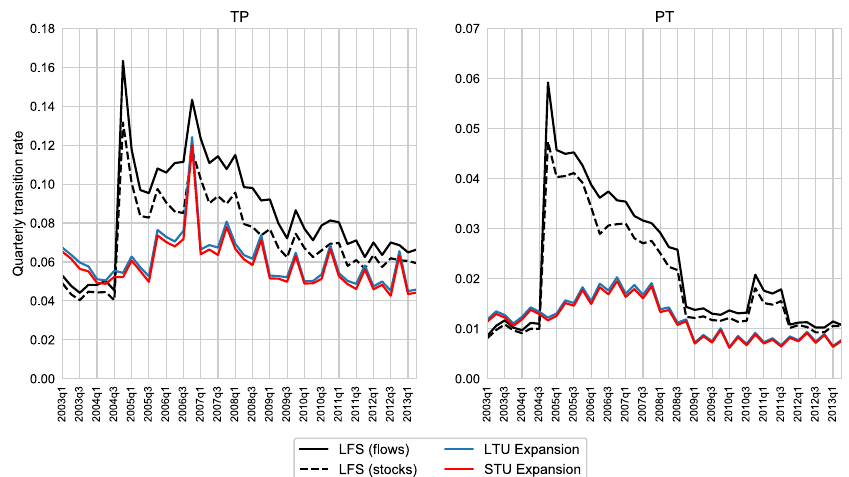
Fig. 23 Quarterly flows: between contract types. Source : MCVL and the LFS stocks are consistent over time. Figure 23 shows one of the main breaks in the flows between different types of contracts (TP and PT).